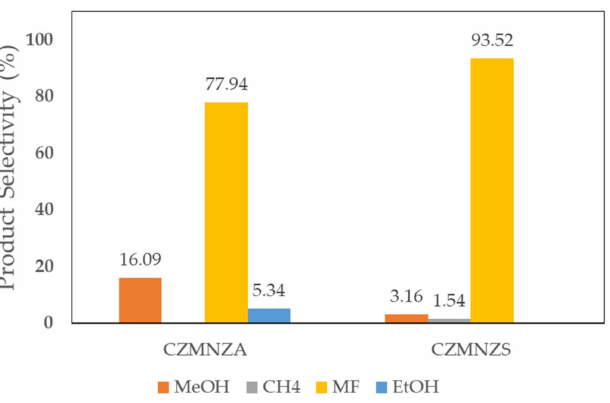
Figure 14. Product selectivity over Al 2 O 3 and SBA-15-supported catalysts at reduction temperature 250 ◦